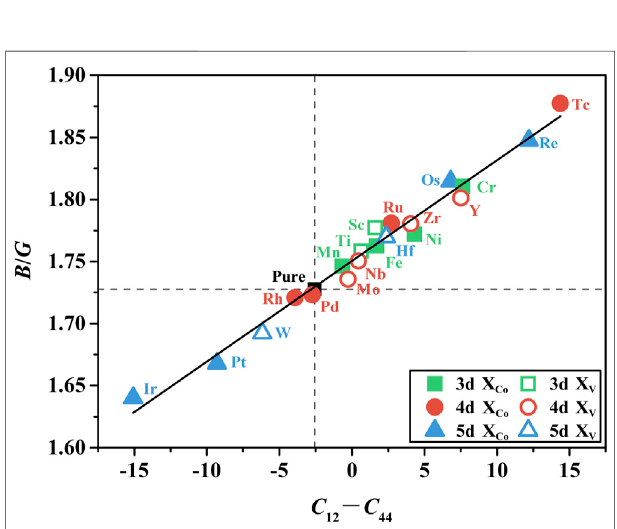
FIGURE 7 | Relationship between Cauchy pressure C 12 – C 44 and B / G ratio of the X-substituted γ ′ -Co 3 (V, Ta).